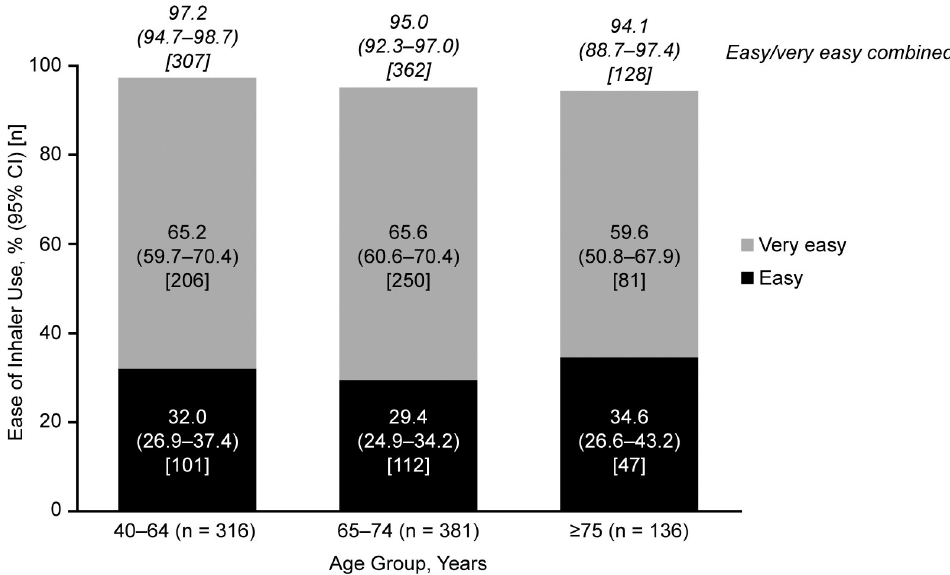
Fig 4. Ease-of-use of the placebo ELLIPTA DPI at study end by age group (n = 833). The 95% CI for the percentages is calculated using the exact binomial distribution. CI, confidence interval; DPI, dry-powder inhaler.